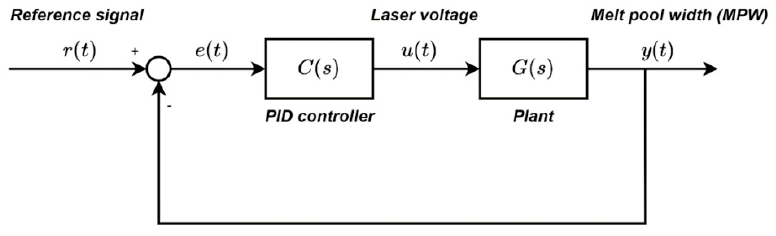
Figure 2. Block diagram of the conventional closed-loop control system for the direct energy deposition (DED) process.